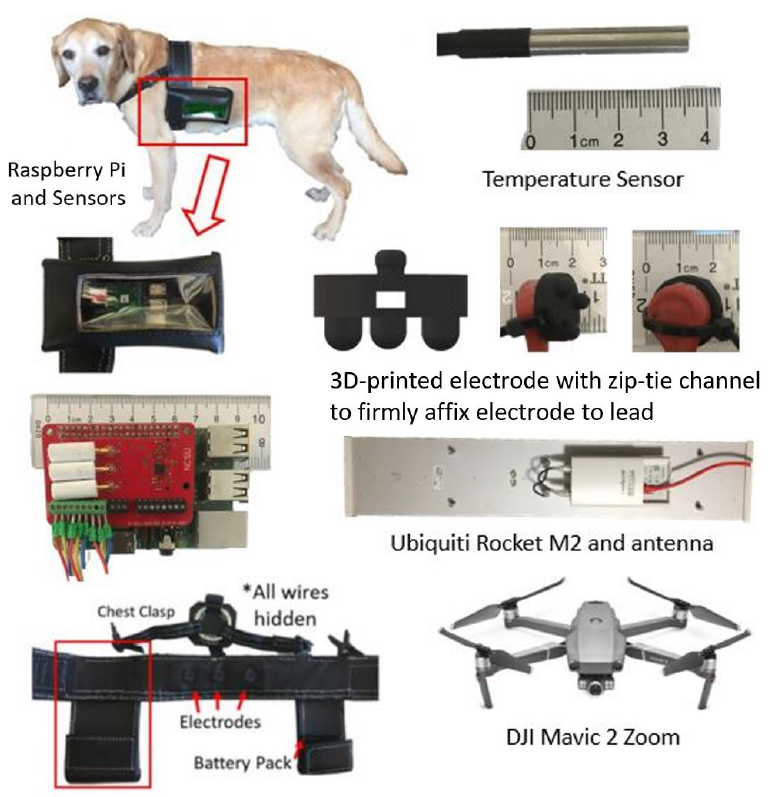
Figure 1. Hardware assembled to enable the on-body and aerial sensor system. A custom designed leather harness houses the microprocessor (highlighted by red box) and sensor in its pouches and hides all the wiring (bottom left). It also hosts custom 3D printed electrodes and temperature sensors. A commercial Wi-Fi router and antenna provide wireless connection to the Cloud. The aerial images acquired by commercial drone’s camera.